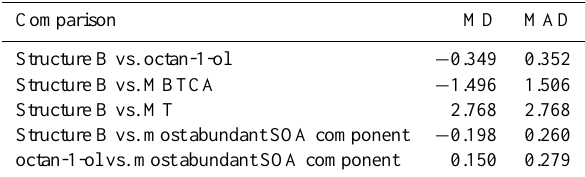
Figure 6. Plot comparing the partition coefficients at 25 ◦ C of alka- nes and their oxidation products between different surrogate “sol- vents” (mimicking the partitioning properties of the water-insoluble organic matter of aerosol) and the gas phase predicted with SPARC. The x -axis is the partitioning coefficient for the surrogate structure B proposed by Kalberer et al. (2004). Table 3. Mean difference (MD) and mean absolute difference (MAD) between the five sets of SPARC-predicted K i, WIOM .